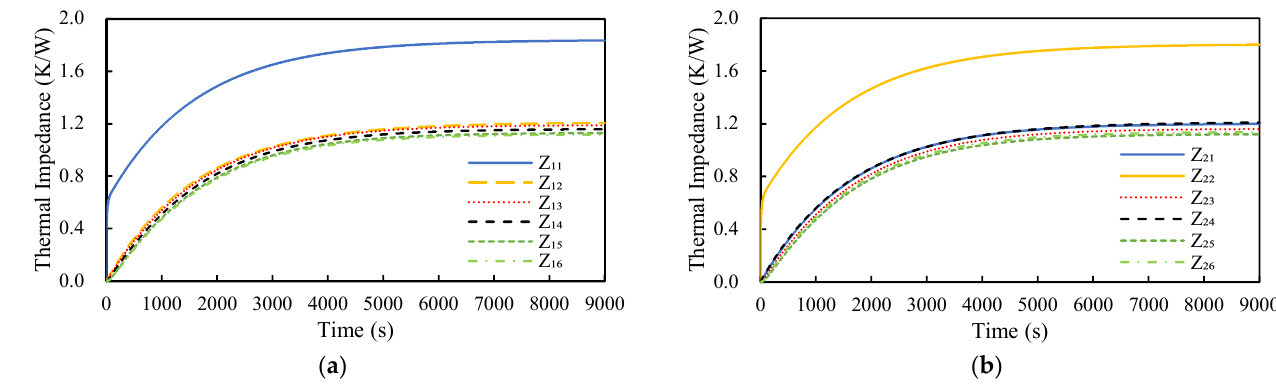
0.00.40.81.21.6 Figure 8. Two examples of the transient thermal impedance curves: ( a ) Z 1 i (t), i = 1,…6 and ( b ) Z 2 i (t), i = 1,…6.